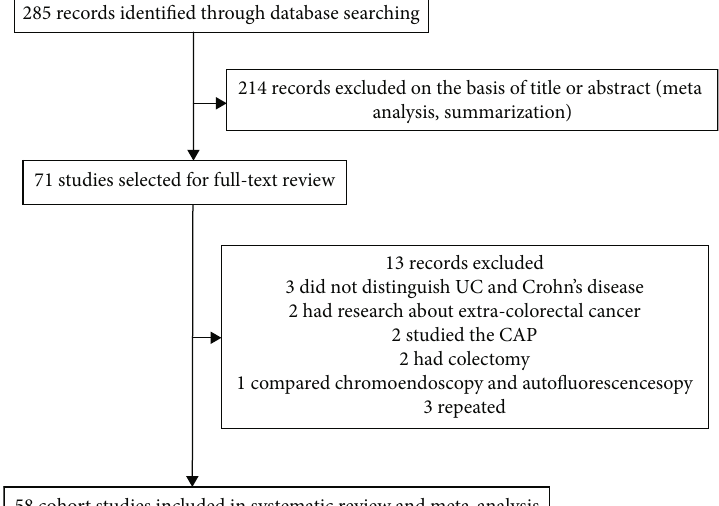
Figure 1: Flow chart of study